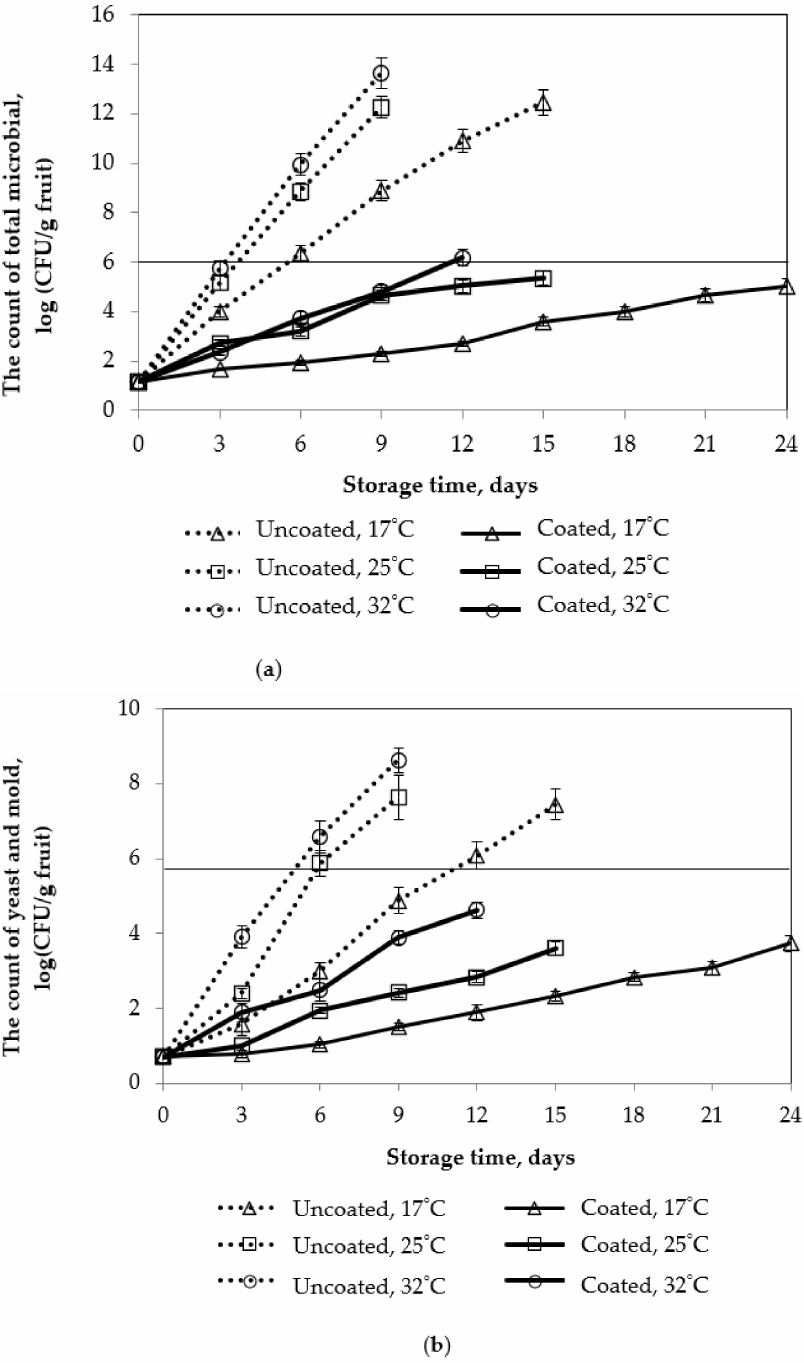
Figure 12. Effect of storage temperature on microbiological analysis of mango fruits. Numbers are the mean ± standard errors of three replications: ( a ) total microbial and ( b ) yeasts and molds. The lower the storage temperature is, the smaller the number of microbes is. These results showed that yeasts, molds, and bacteria were present in the mango fruits. The reduction in microbial counts on the surface of coated mango samples is due to the